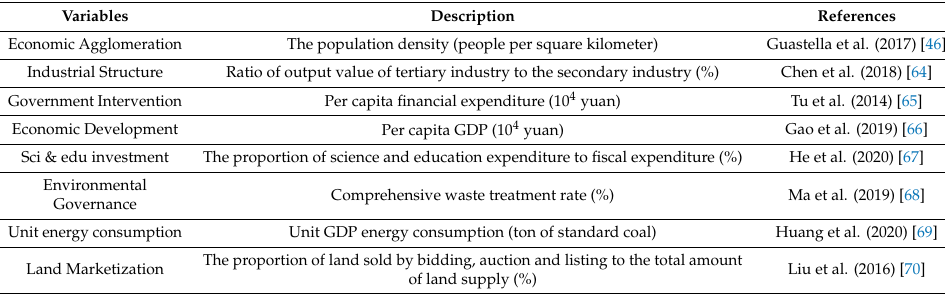
Table 2. Influencing factors of